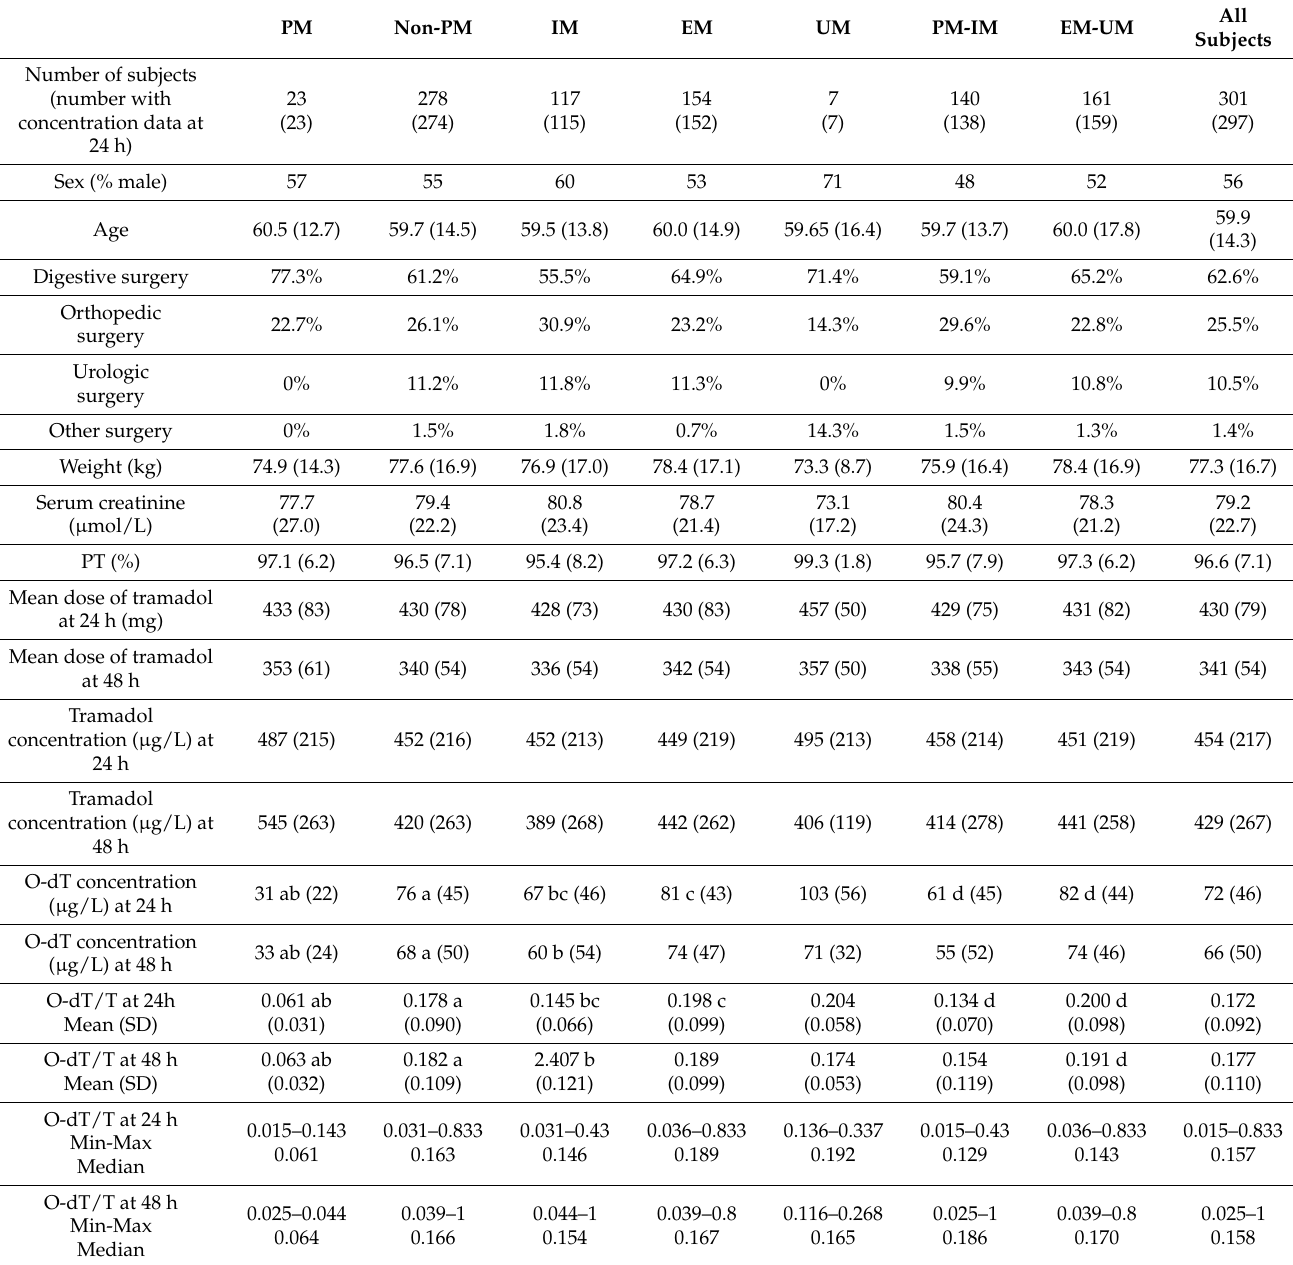
Table 2. Patients’ characteristics according to phenotype.